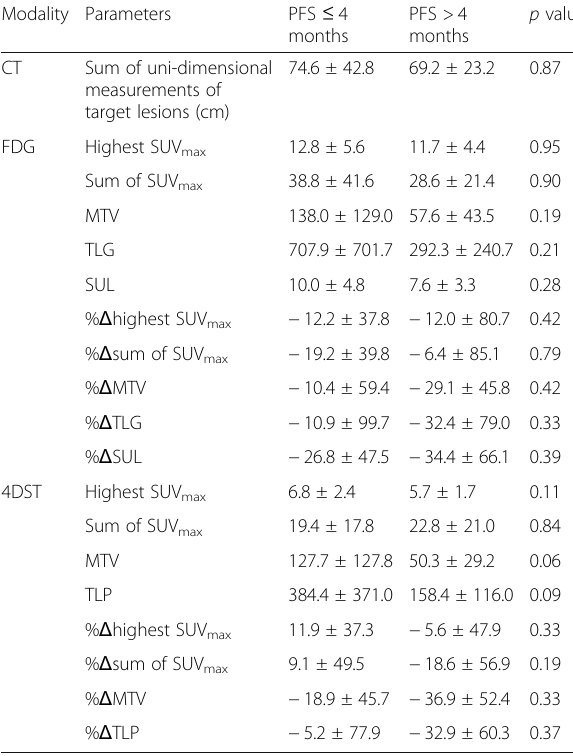
Table 3 Difference in parameters with PFS > 4 months versus PFS ≤ 4 months Modality Parameters